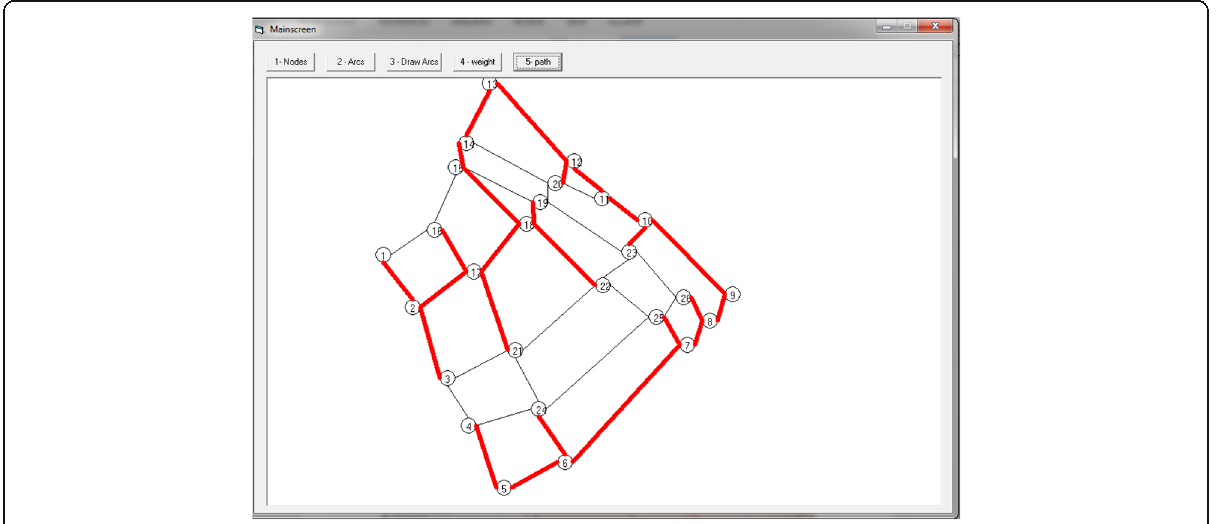
Fig. 19 The Results Derived from Implementing the Model of hazardous land Uses Index on the Sample Data using